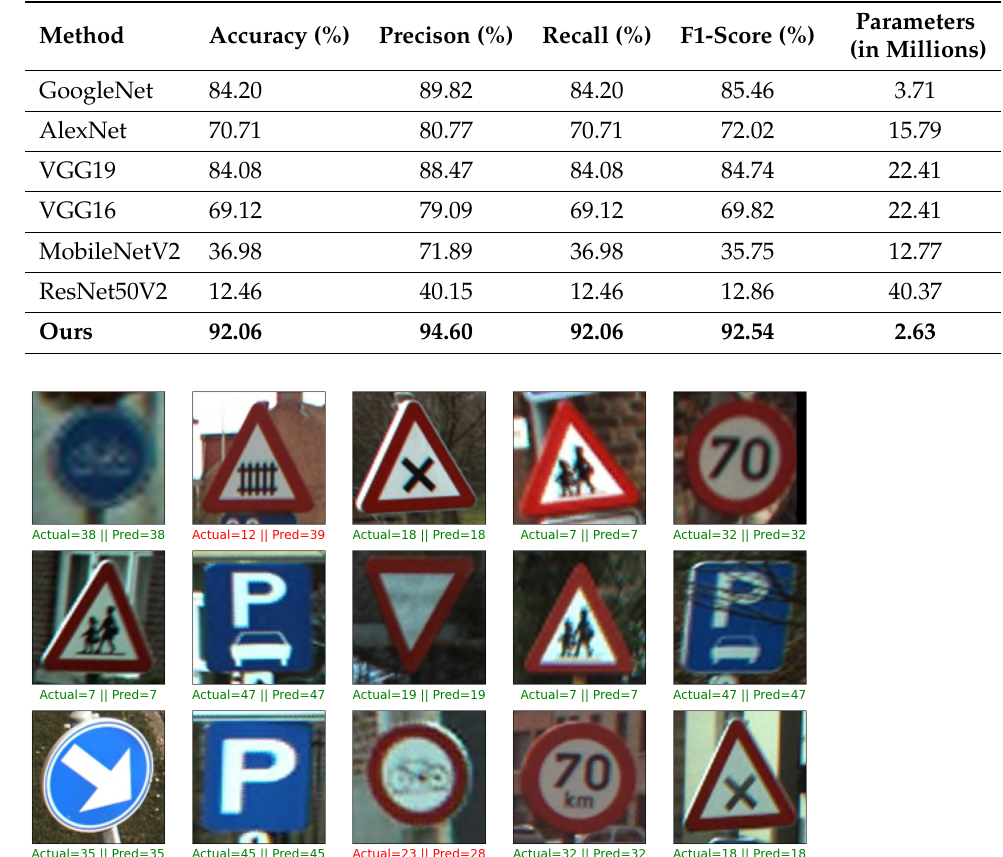
Figure 6. Detection and classification performance of proposed model on